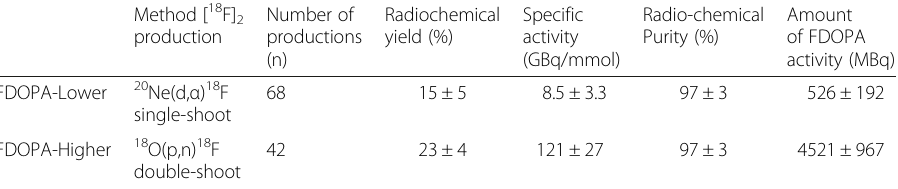
Table 1 An overview is given of the [ 18 F] 2 production method, number of productions, the radiochemical yield, the specific activity, radiochemical yield, radiochemical purity and the amount of FDOPA activity